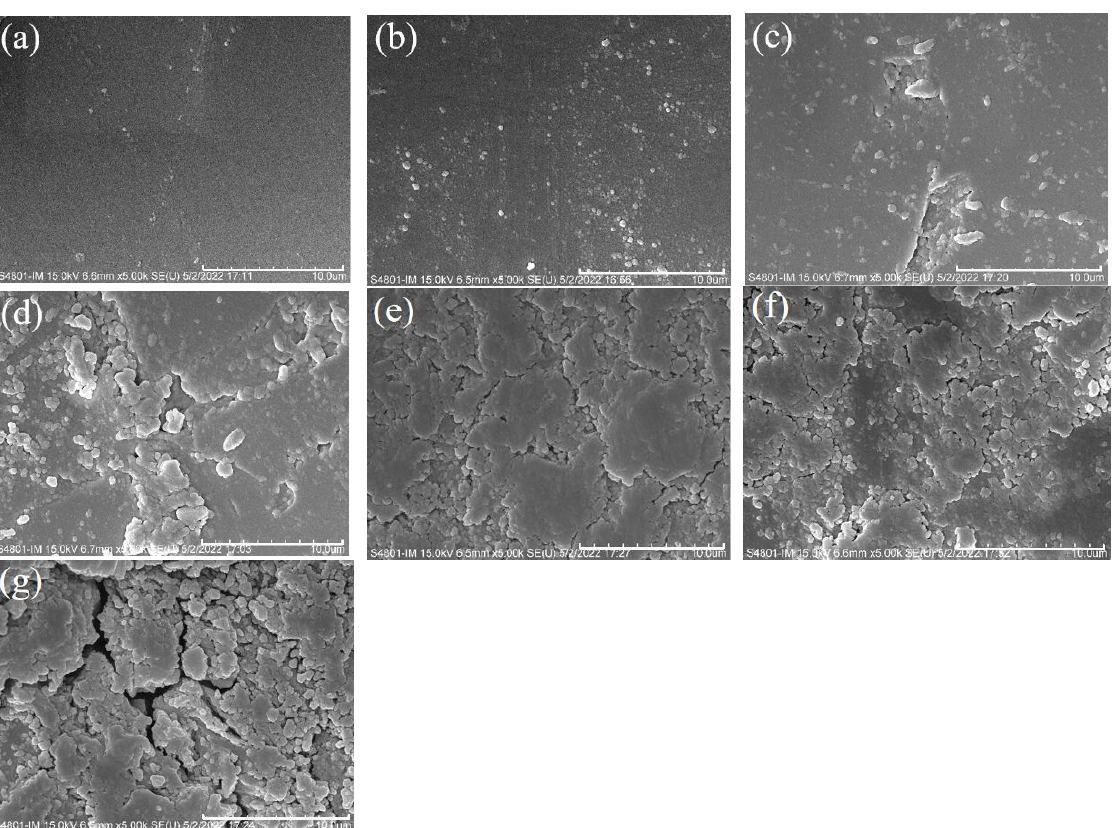
Figure 7. The SEM images of samples in different ageing stages at 5000 times magnification. ( a ) 0 h; ( b ) 60 h; ( c ) 180 h; ( d ) 300 h; ( e ) 600 h; ( f ) 900 h; ( g ) 1200 h.